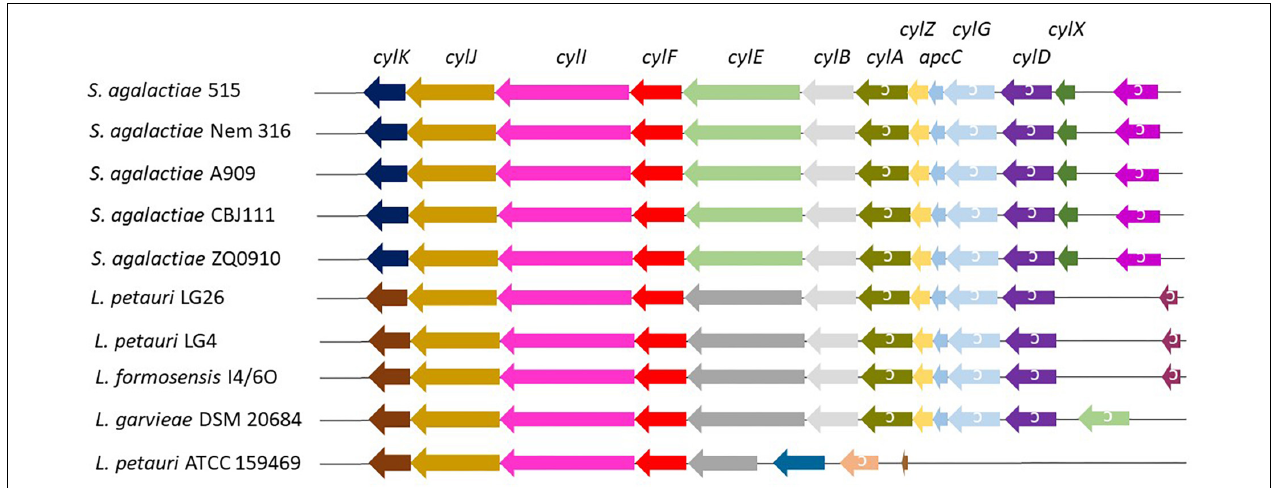
FIGURE 4 | Cyl operon in S. agalactiae and L. garvieae/petauri/formosensis . Analogs of the cyl operon of three pigment-producing S. agalactiae (Six et al., 2016, see below) in L. garvieae/petauri/formosensis were extracted using the genome browser function implemented in Edgar. Genes are not drawn according to scale. TABLE 1 | Effect of different carbohydrates in Wilkins–Chalgren medium on the orange pigment formation. Effect of substrate (5 g L − 1 ) in Wilkins–Chalgren Orange pigment production on granadaene production